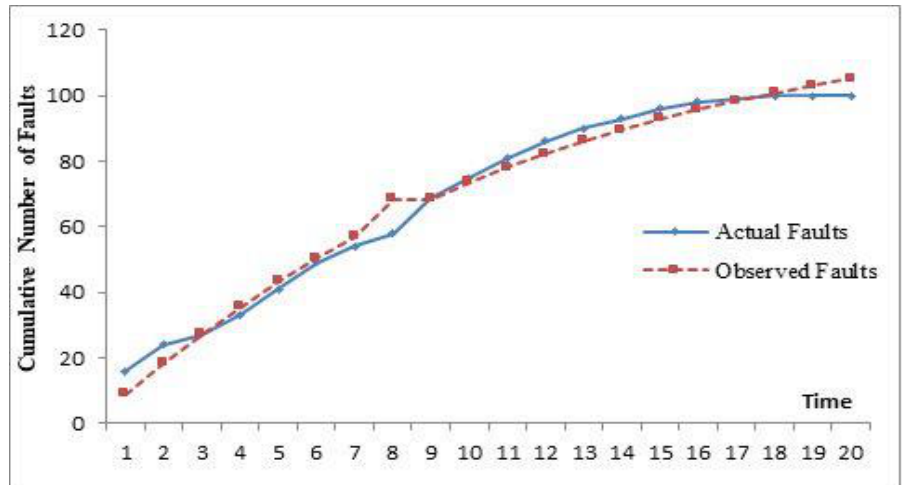
Fig. 1. Goodness of fit curve for Release I